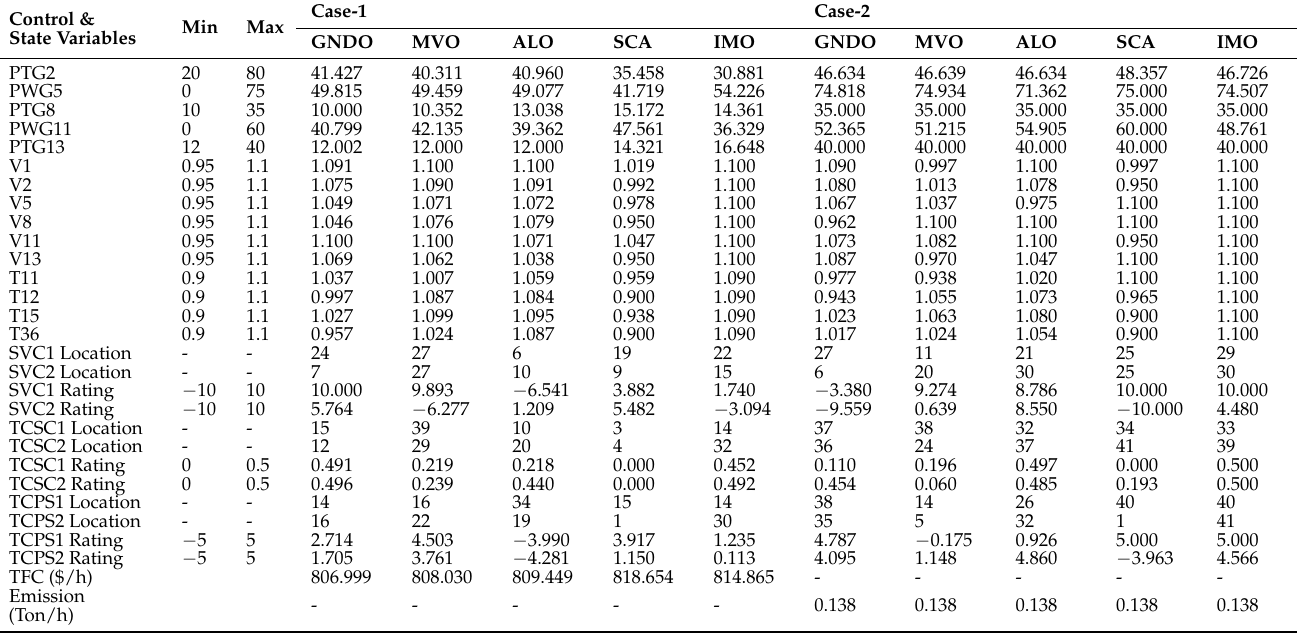
Table 9. Single objectives simulation results for case 1 and case